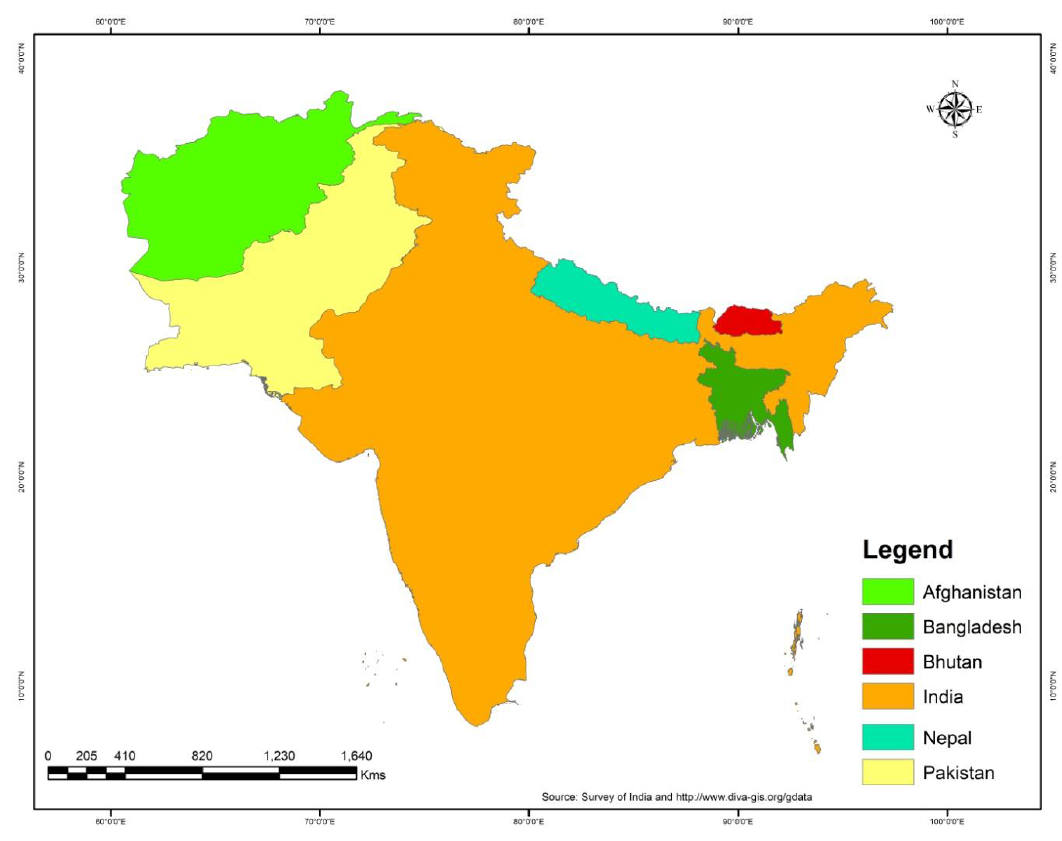
Figure 1. Map showing the south Asian countries (Afghanistan, Bangladesh, Bhutan, India, Sri Lanka, Maldives, Nepal and Pakistan). Table 1. Trends in different classes of agriculture land area (1000 ha) in south Asian countries from 1962 to 2012.